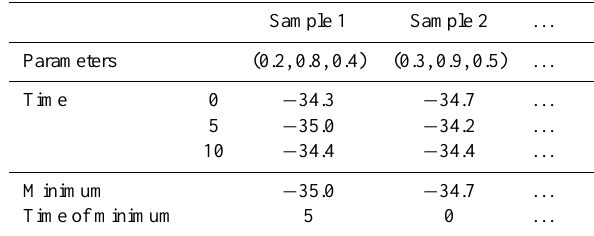
Table 1. Illustration of process histories of length 3 on a time grid of 5kyr intervals. For each sample, we simulate the parameters from a joint posterior distribution, followed by a realisation of the latent process x g . Two examples of non-linear functionals of x g are dis- played in the last two rows.